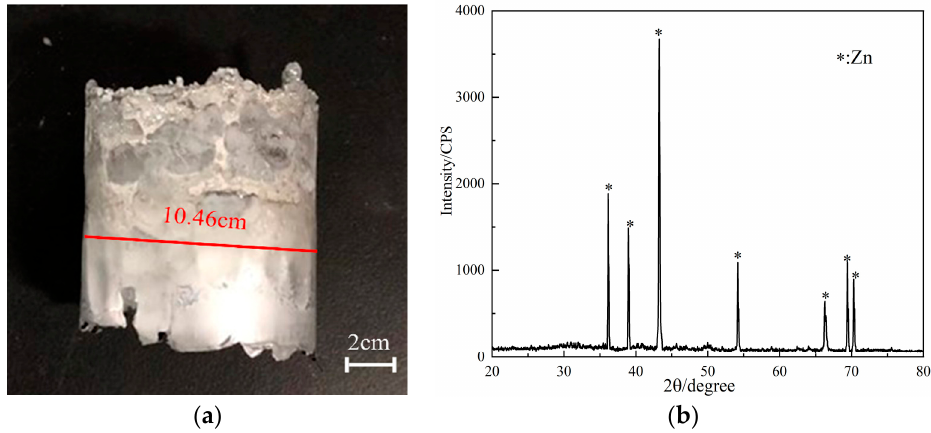
Figure 7. Condensate collected and XRD analysis: ( a ) condensate collected ( b ) XRD analysis.